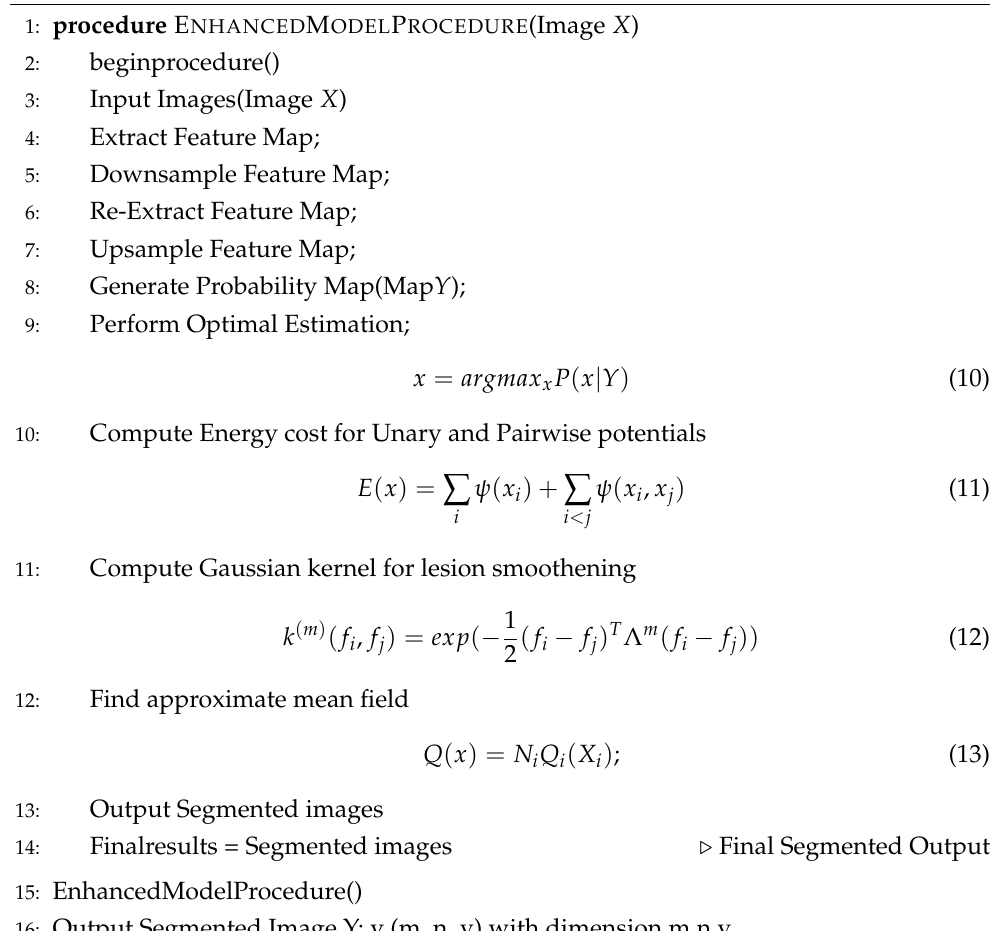
Algorithm 1 Efficient Algorithm for Skin Lesion